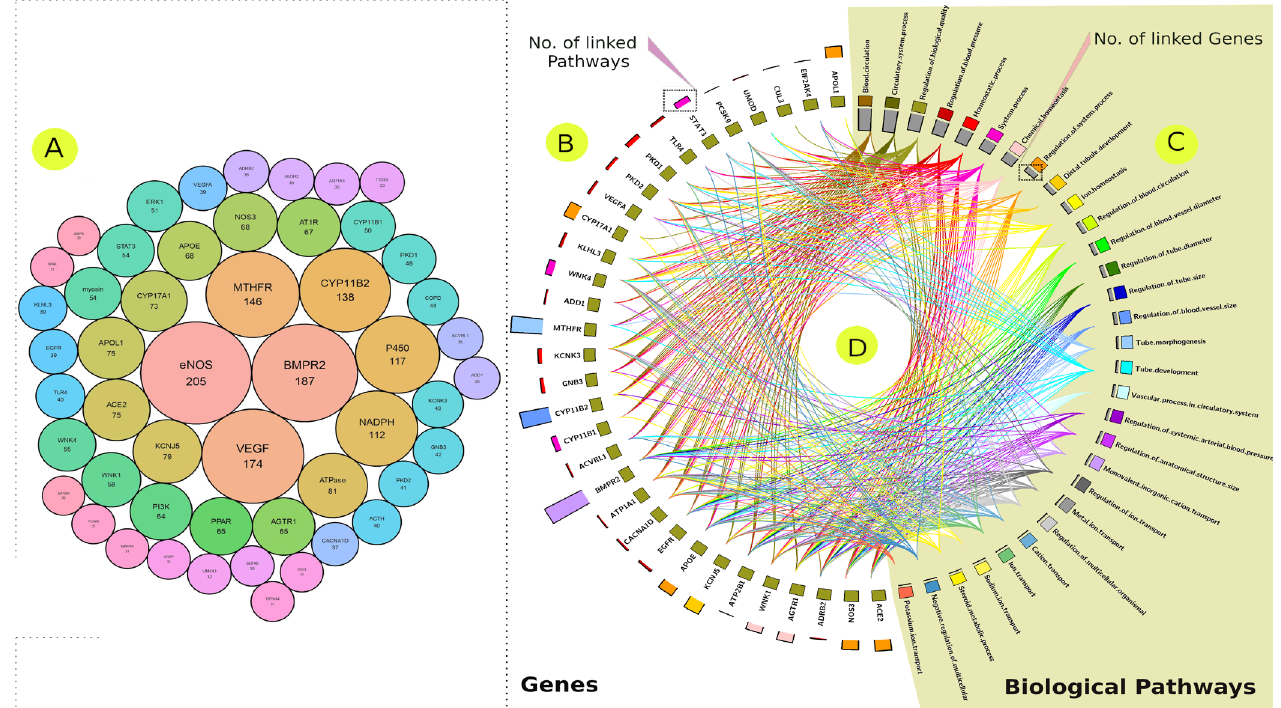
Figure 9. The most frequently mentioned genes in the hypertension literature ( A , B ). The size of the circle, as well as the numbers included, represent the number of articles that mentioned a genetic link between these genes and EH disorder ( A ). The most frequently mentioned genes in the hypertension literature and their corresponding biological processes according to the enrichment analysis ( C ). The histogram depicts the number of hypertension publications that listed these genes ( A , B ). Biological processes were allocated to hypertension-associated genes ( C ), with gray bars representing the number of genes found within these processes and colored connections representing genes that contribute to these processes. A colored link is shown between the biological process and the corresponding EH-linked genes, with each gene potentially linked to multiple pathways or vice versa ( D ).